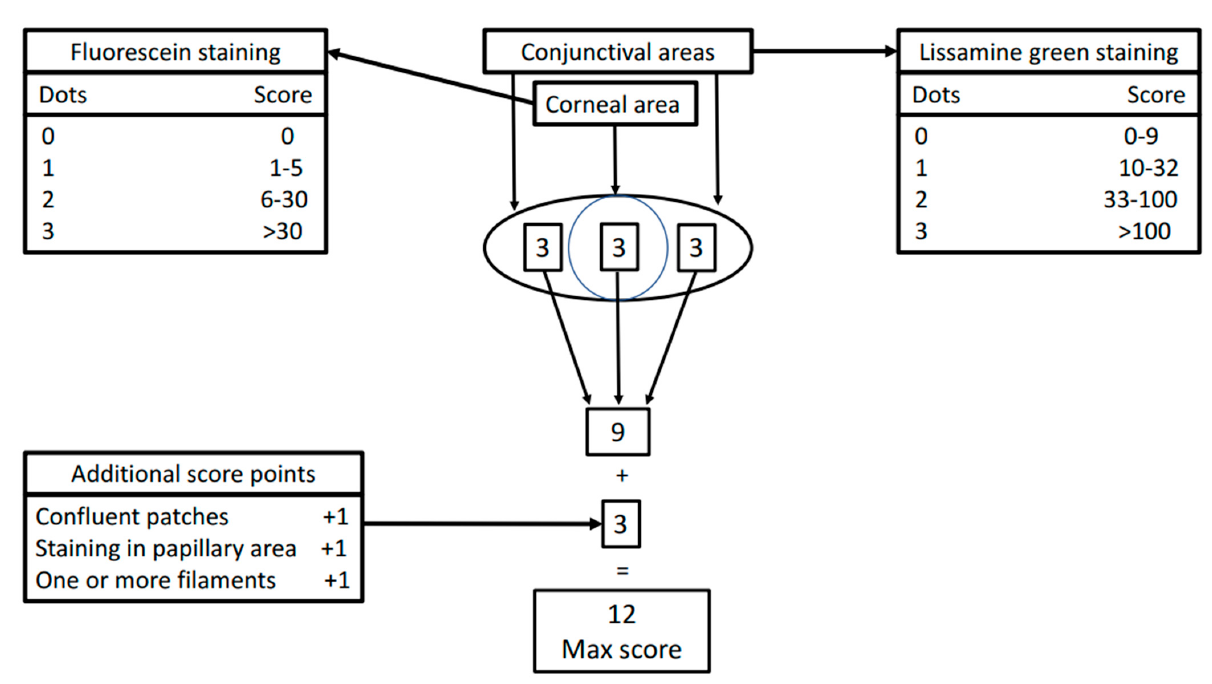
Figure 1. Ocular Staining Score (OSS): a graphical representation of the scoring method of this ophthalmologic test for the assessment of epithelial lesions on ocular surface in pSS.